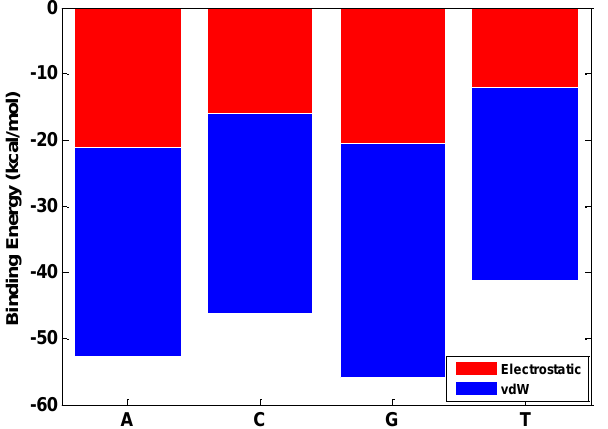
Figure 4. Contribution of van der Waals (vdW) and electrostatic interaction in the binding energy between hBN and four basic nucleotides.